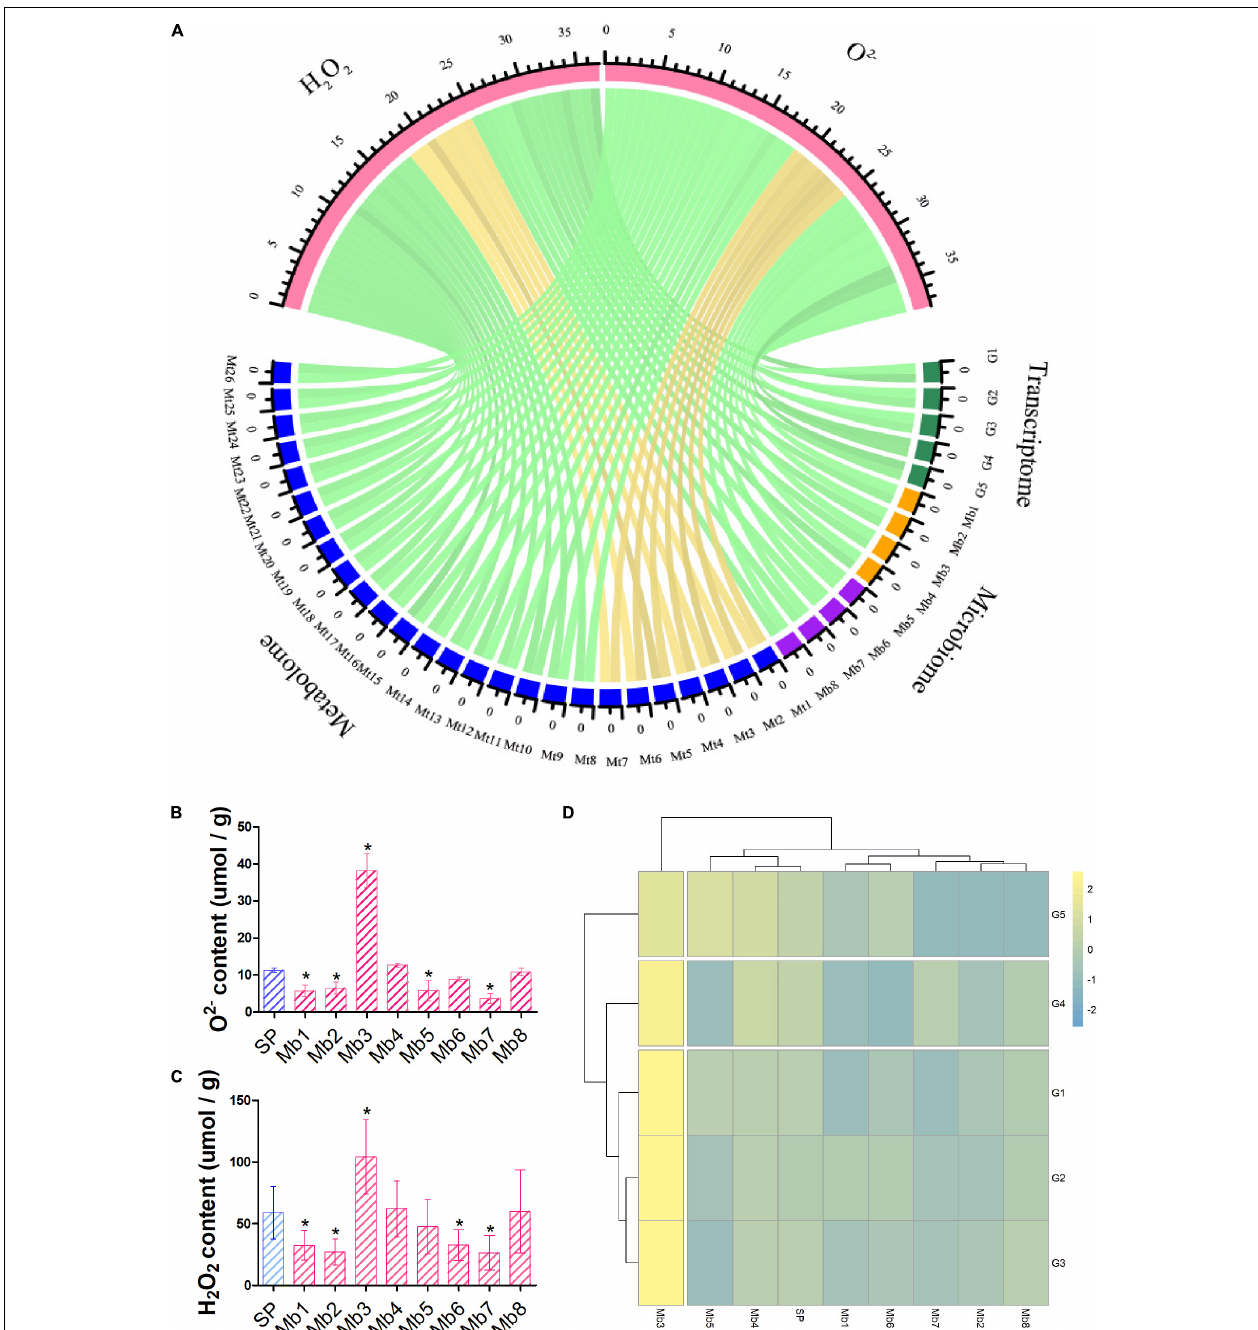
FIGURE 5 | Shortlisting and phenotyping functional microbiota. (A) Correlation between phenotypes (H 2 O 2 and O 2 − ) and their highly correlated ( p < 0.05) transcripts, metabolites, and microbes of different AMPSs are presented as a chord diagram. Gold and green represent positive and negative between samples, respectively. The functional microbes (Mb1–Mb8) were assembled with aseptic PWN and used to inoculate pine trees, and then O 2 − (B) and H 2 O 2 (C) contents and expression level of highly correlated response genes (D) in different samples were measured and are represented as mean ± SD. G1–G5 indicate different transcripts ( c64867.graph_c0 , c81022.graph_c0 , c62681.graph_c0 , c68789.graph_c0 , and c70340. graph_c0 ); Mt1–Mt26 indicate different metabolites [3alpha,6alpha-mannotriose, cellobiose, Glu-Gly-Arg, maltotriose, stachyose, thiazolidine-2-carboxylic acid, tyramine, 1,2-di-(9Z-octadecenoyl)-sn-glycero- 3-phosphocholine, 1-hexadecanoyl-2-(9Z-octadecenoyl)-sn-glycero-3-phosphoethanolamine,1-hexadecanoyl-2-octadecadienoyl-sn-glycero-3-phosphocholine, 5-amino-2-methoxyphenol, arachidonic acid (peroxide free), hydroxy-benzene acetic acid, dihydrotachysterol, heptadecanoic acid, hexacosanoic acid, lanosterol, linalool oxide, myo-inositol, nervonic acid, oleoylglycine, non-apropylene glycol, octapropylene glycol, pifithrin-alpha, sterigmatocystin, and uvaol]; and Mb1–Mb8 indicate different microbial genera ( Cladophialophora, Ochroconis, Penicillium, Trichoderma, Achromobacter, Chitinophaga, Flavobacterium , and Nubsella , respectively); SP indicates sterilized PWN. “*” represents a significant difference compared with SP (Student’s test, p < 0.05).